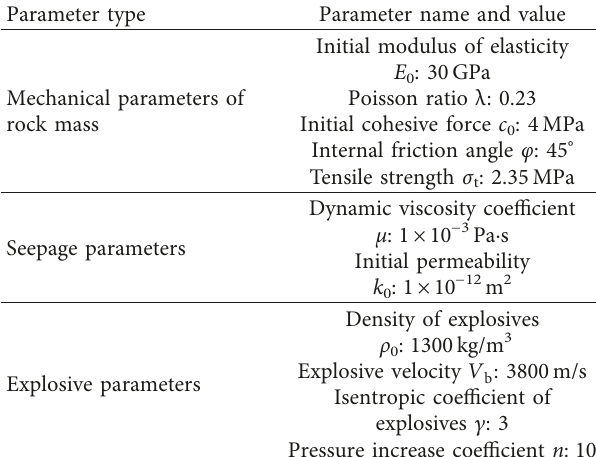
Figure 3: Sketch of mining method. Table 1: Partial parameter value.